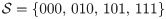
Persistent homology of a sample of genetic sequences.Barcode and Vietoris-Rips complexes at several values of the parameter ϵ, for the sample of sequences S={000,010,101,111}. Only the first homology group (H1) is shown. At small ϵ the four sampled points are disconnected. Increasing ϵ leads to a loop, that appears as a single element of H1. Further increasing ϵ fills in the loop, leading to a single connected surface. An ultra-minimal ARG explaining S, and the corresponding tARG are shown in Fig 2 (bottom). The barcode only captures one of the Rmin = 2 recombination events.